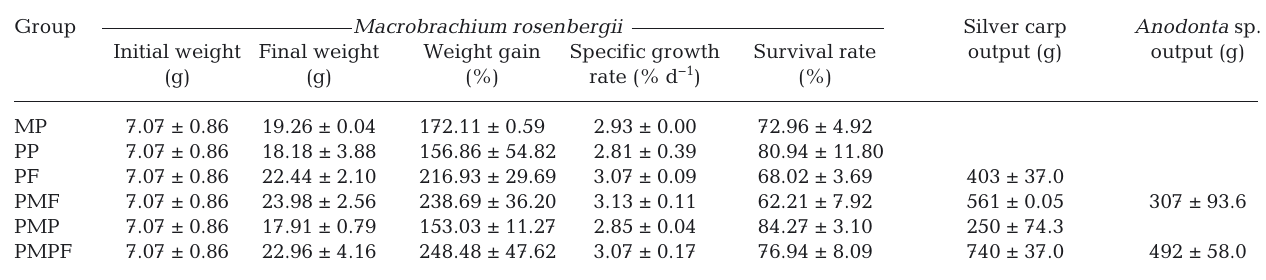
Table 1. Mean ± SE weight gain of the prawn Macrobrachium rosenbergii and final weight of the prawns and output of carp and mus- sles (with shells) in different experimental treatments after 64 d. Treatment groups are as follows; MP: monoculture prawn; PP: prawn in culture with aquatic plants (duckweed Lemna minor ); PF: prawn with fish (silver carp Hypophthalmichthys molitrix ); PMF: prawn with mussels ( Anodonta sp.) and fish; PMP: prawn with mussels and aquatic plants; PMPF: prawn with mussels, aquatic plants and